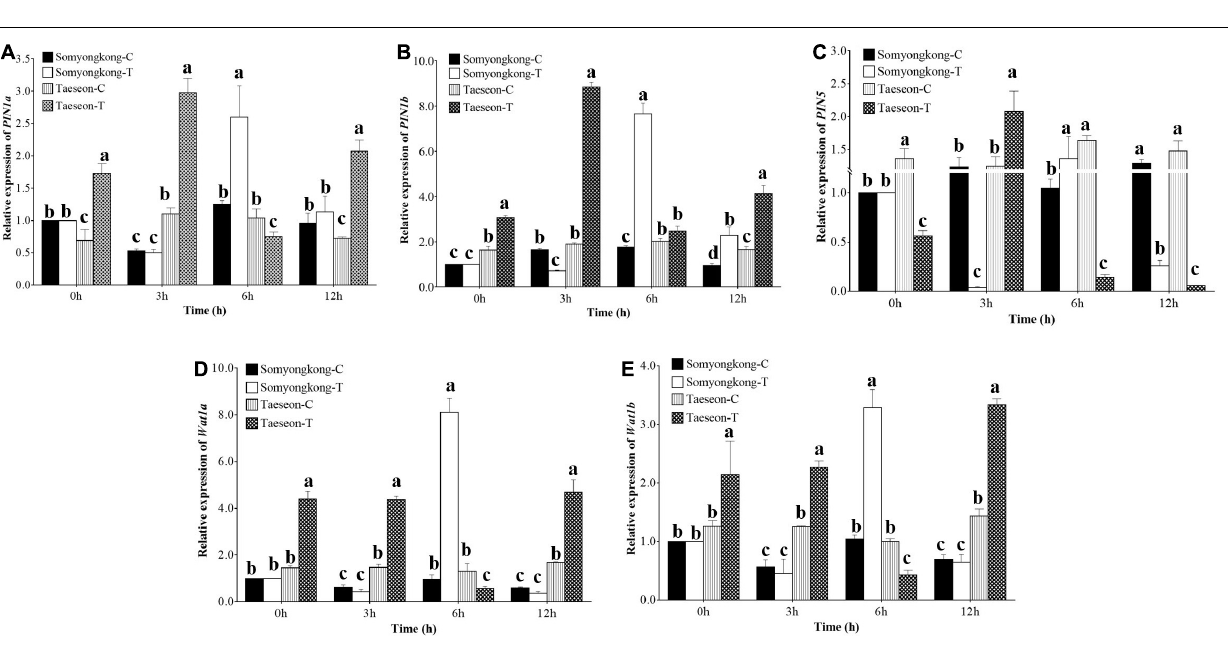
FIGURE 9 | Relative expression levels of root auxin transporter genes. Expression levels of PIN1a, (A) PINb, (B) PIN5, (C) WAT1a, (D) WAT1b, and (E) genes in the roots of control (C) and Si-treated (T) Somyongkong and Taeseon cultivars at different periods. All values are mean ± SE ( n = 3). Error bars indicate a standard error and different letters indicate the significant differences ( P < 0.05) between treatments using the T